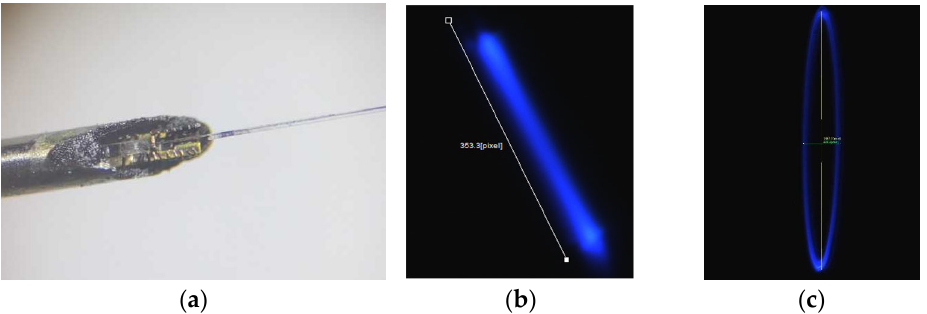
Figure 22. Sample with design E actuator configuration: ( a ) cantilever-actuator assembly; ( b ) scan performed by the fiber tip in case of asymmetric fiber facing hot arm; ( c ) scan from fiber tip in case asymmetry towards the cold